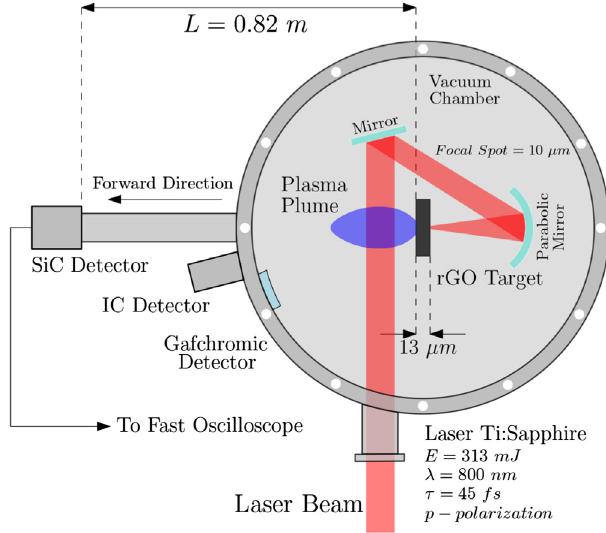
FIG. 1. Schematic of the experimental